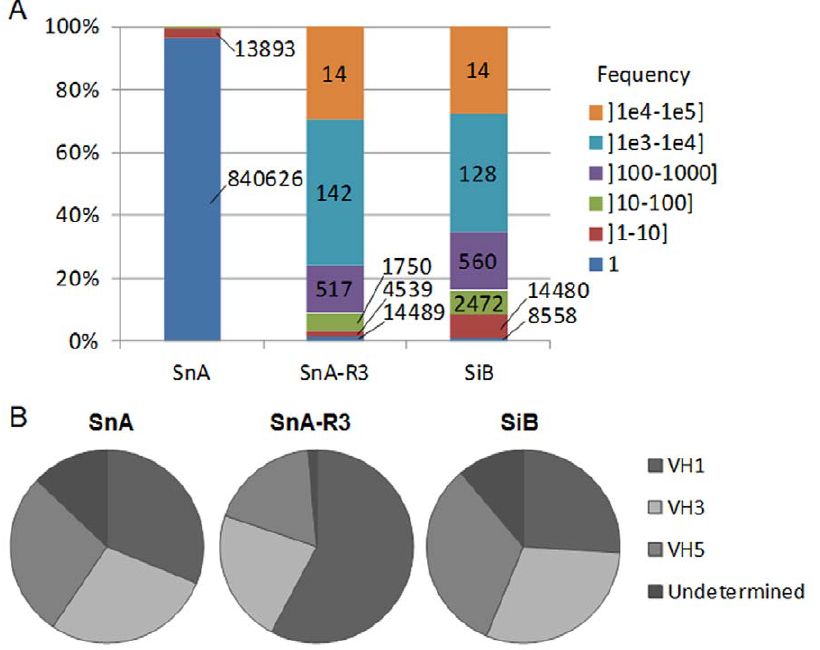
Figure 4. Analysis of synthetic CDRH3 diversity in SnA, SnA-R3 and SiB. Evaluation by NGS of the diversity of synthetic CDRH3 from SnA, SnA-R3 and SiB (one million sequences were analyzed for each) and their repartition into human frameworks. (A) The percentage of CDRH3 in function of their frequency is represented by a color code. The values on the histograms are the number of unique CDRH3 corresponding to each section. (B) Frameworks repartition by family VH1, 3 or 5 in each library and in the selection round SnA-R3. Undetermined are sequences for which no framework could be attributed due to frame shifts. doi:10.1371/journal.pone.0043471.g004 PLOS ONE |